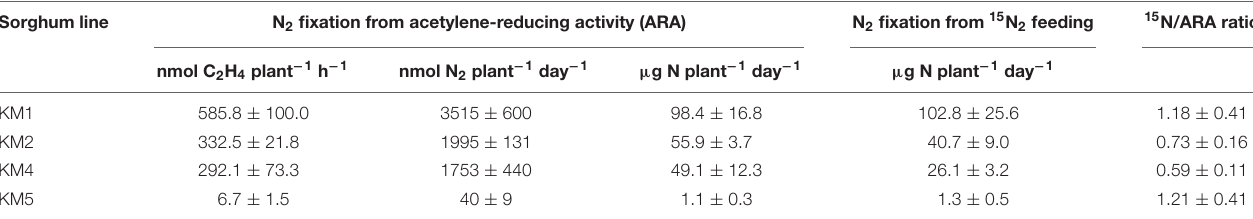
Table S3 for KM1, Supplementary Table S4 for KM2) and did not include vnfH , anfH , or archaeal nitrogenase